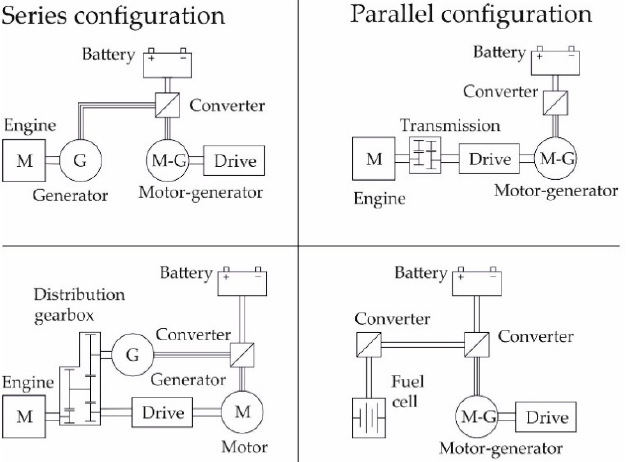
Figure 3. Types of electro-hybrid drive arrangement.